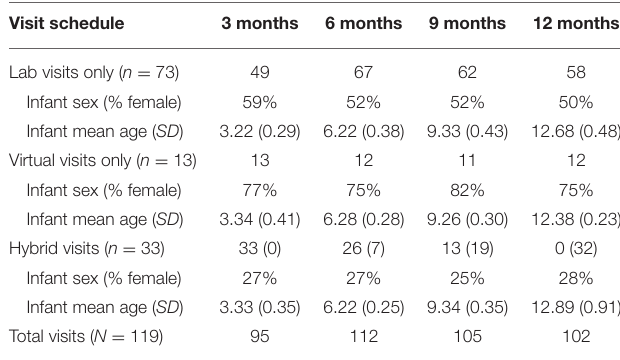
TABLE 1 | Sample sizes and infant characteristics for mother-infant dyads participating in lab visits only, virtual visits only, and hybrid visits (lab and